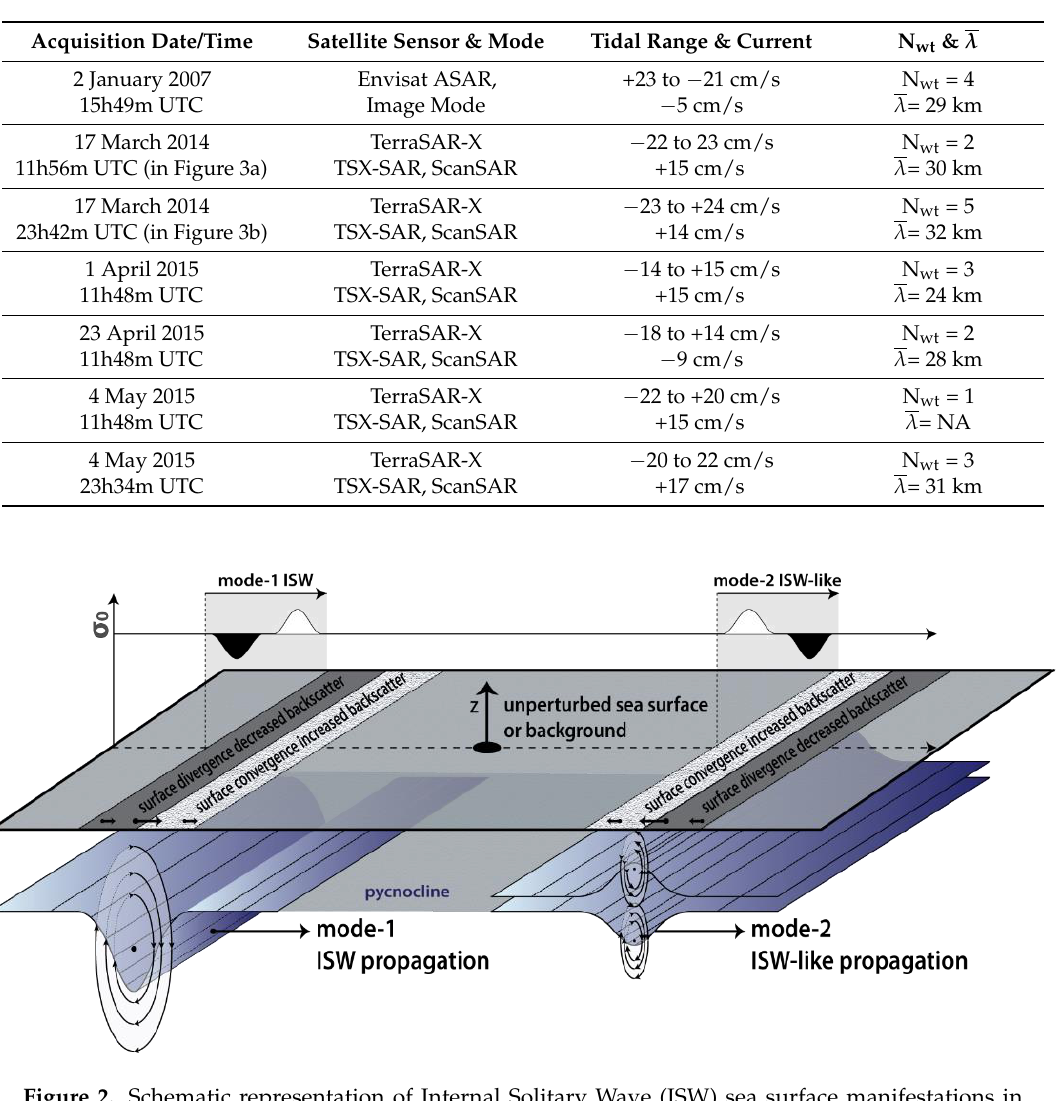
Table 1. List of images used in this study and in the composite map in Figure 1 (solid black lines). Tidal ranges within spring-neap cycles are given together with tidal currents (along the waves’ direction of propagation) at time of acquisition. The number of wave-tail envelopes (N wt ) in each image is also shown with an averaged value for the length between consecutive wave-tails ( λ ).